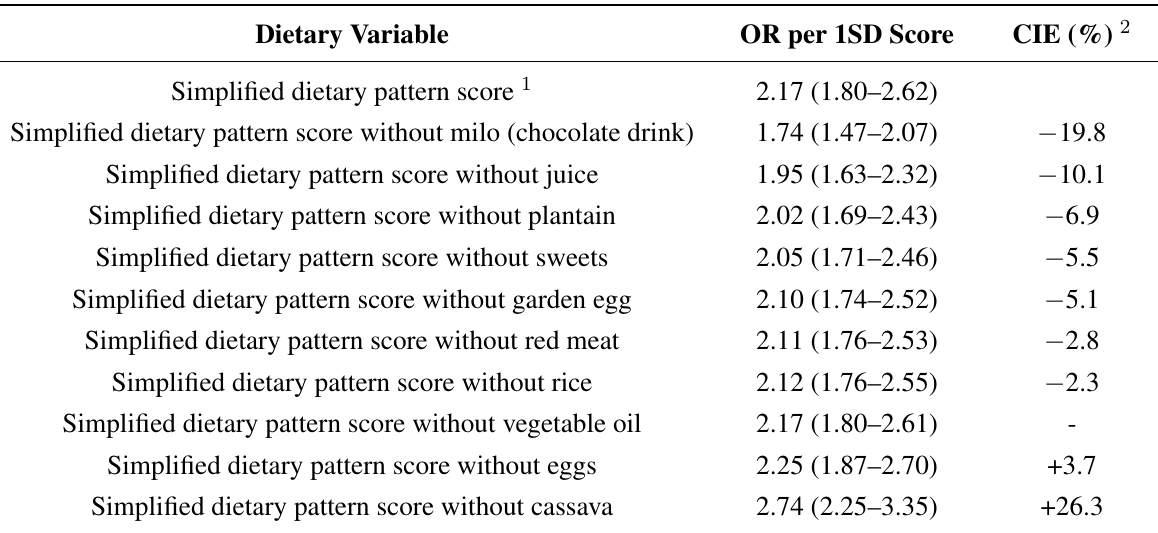
Table 5. Importance of individual components of the simplified dietary pattern score among the total study population ( n =